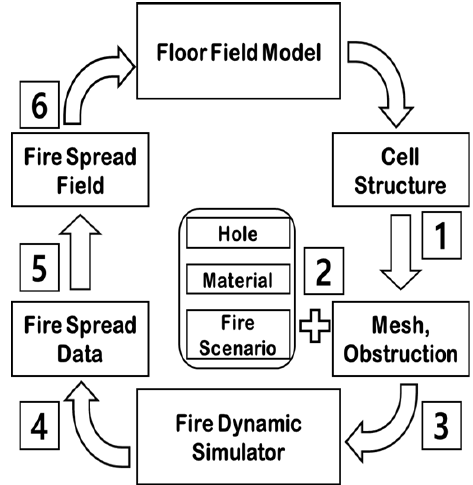
Figure 4. Data linkage in FFM and FDS